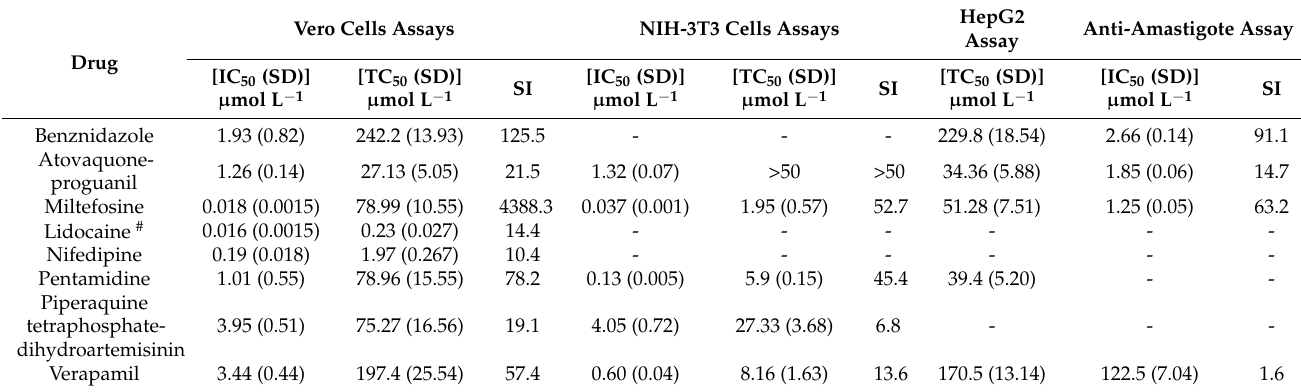
Table 2. Average IC 50 , TC 50 and SI values of the seven primary active drugs. These were tested in phenotypic assays based on Vero, NIH-3T3 and HepG2 cells.